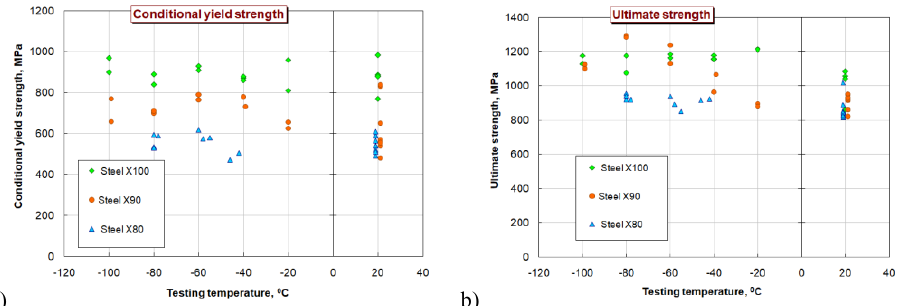
Fig. 2 . Comparison of strength characteristics: conventional yield strength (a) and ultimate tensile strength (b).